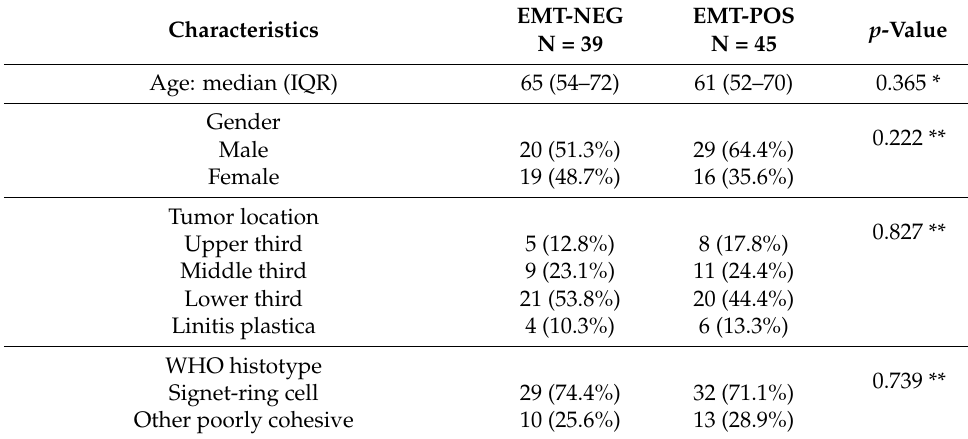
Table 1. Association between EMT status and clinical–pathological variables in MSS diffuse-type gastric